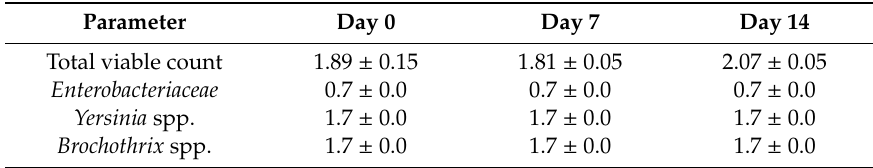
Table 2. Mean and standard error values of microbiological parameters of the rolled fillets of ham on the treatment day and storage days 7 and 14 ( n =